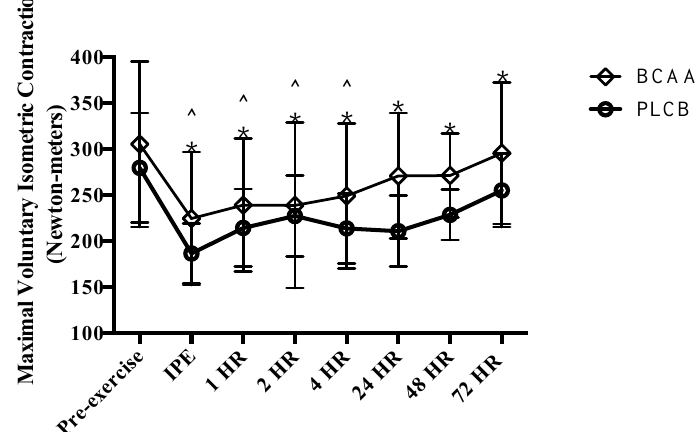
Figure 3. Mean (± standard deviation) force production (Newton-meters) pre-eccentric exercise, immediate post (IPE), 1, 2, 4, 24, 48 and 72 hours (HR) for resistance trained men supplementing with branched-chain amino acids (BCAA) or placebo (PLCB) ( n = 20). * = significantly different from pre-exercise ( p < 0.05) for PLCB. ^ = significantly different from pre-exercise ( p < 0.05) for BCAA.